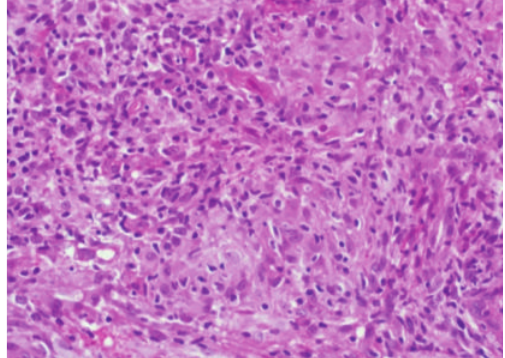
Figure 2: Of patient no. 1 showing histopathological section of lesions showing lymphocytes, macrophages, and poorly formed epithelioid granulomas (H&E stain ×